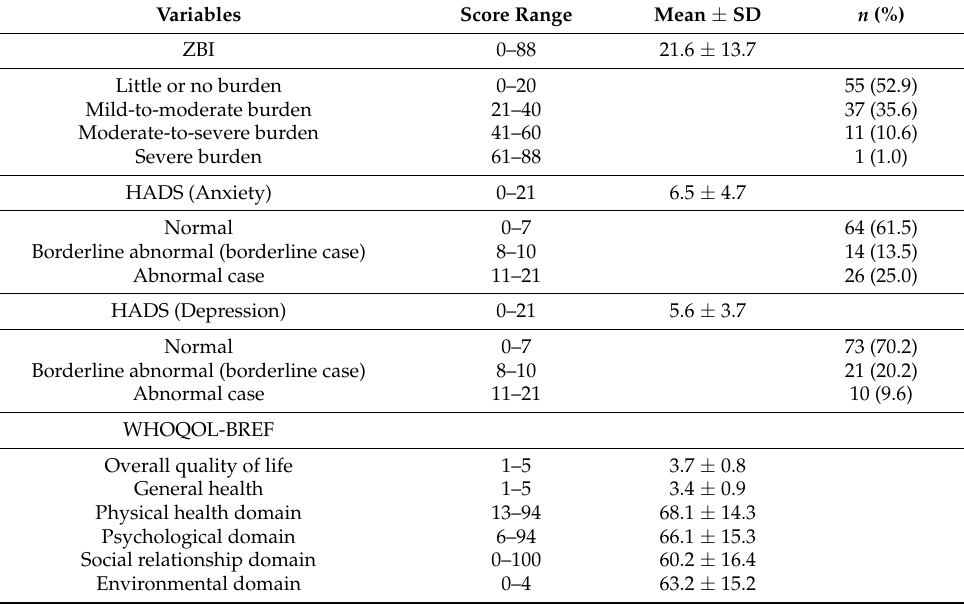
Table 2. Questionnaire response scores n = 104.